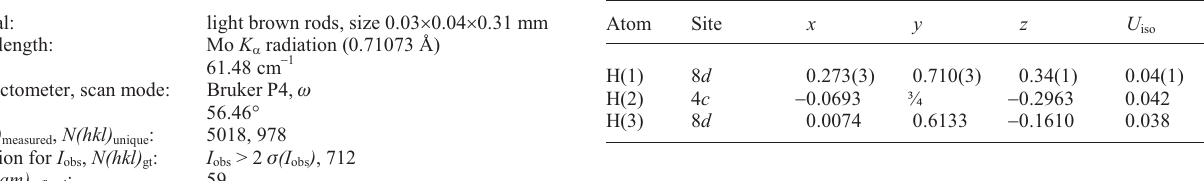
Table 1. Data collection and handling. Table 2.